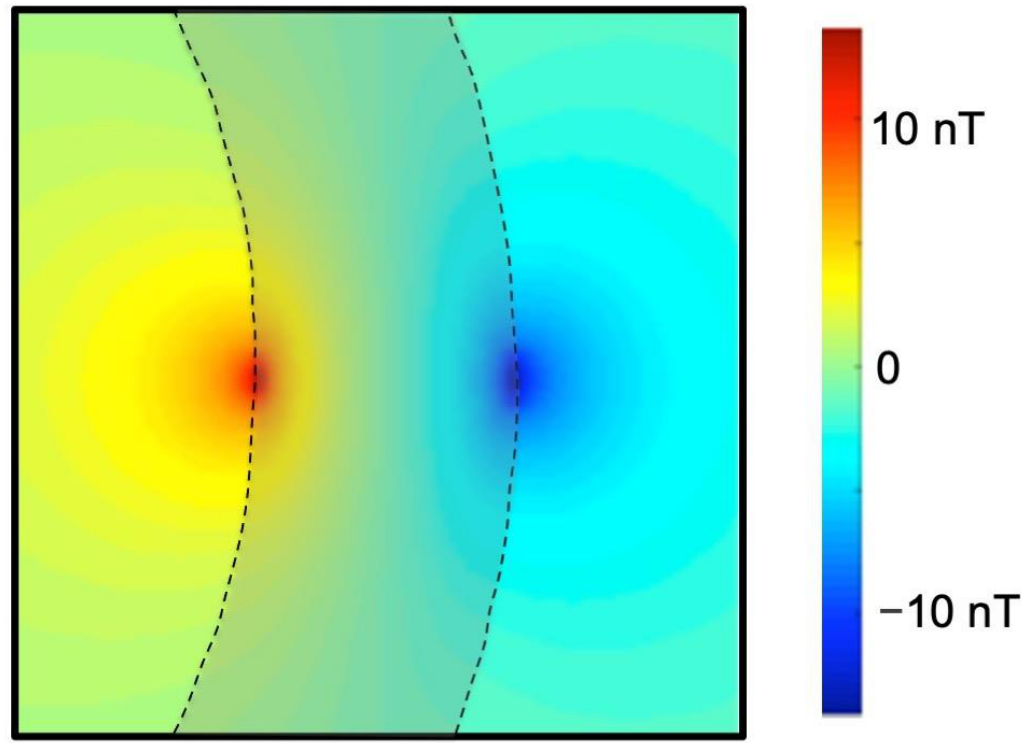
Figure 1. The magnetic field produced by an action potential wavefront in the heart. The heart is spherical and only a portion of the heart wall is shown (shaded, 1 cm thick). On the left is part of the blood cavity enclosed by the heart and on the right is part of the bath surrounding the heart. A wavefront propagates from top to bottom, with the upstroke positioned halfway down. Red corresponds to the magnetic field directed into the paper and blue out of the paper. Adapted from Figure 5 of [8].